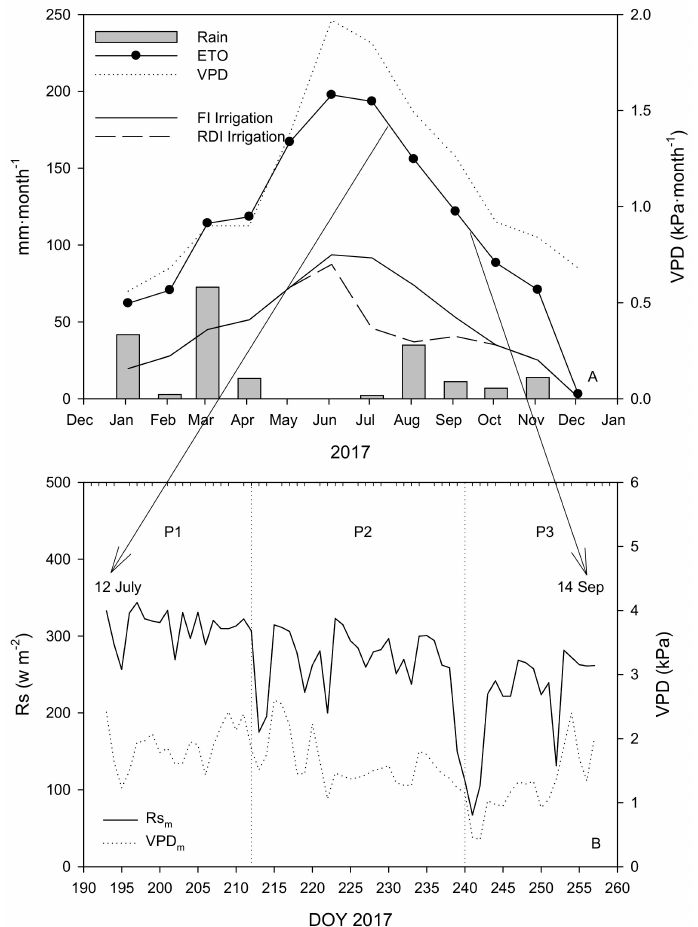
Figure 1. ( A ) Seasonal evolution of rainfall (mm · month − 1 ), full and regulated deficit irrigation (mm · month − 1 ), reference evapotranspiration (ET · month − 1 ), and vapor pressure deficit (VPD, 0 , mm kPa · month − 1 ) during 2017. ( B ) Daily mean of VPD and solar radiation (Rs m , w · m − 2 ) during the experimental period (from DOY 193 to 257 of year 2017). The discontinuous vertical lines divide the experimental period into three periods with a different water stress level: Period 1 (P1, DOY 193-212), Period 2 (P2, DOY 213-239), and Period 3 (P3, DOY